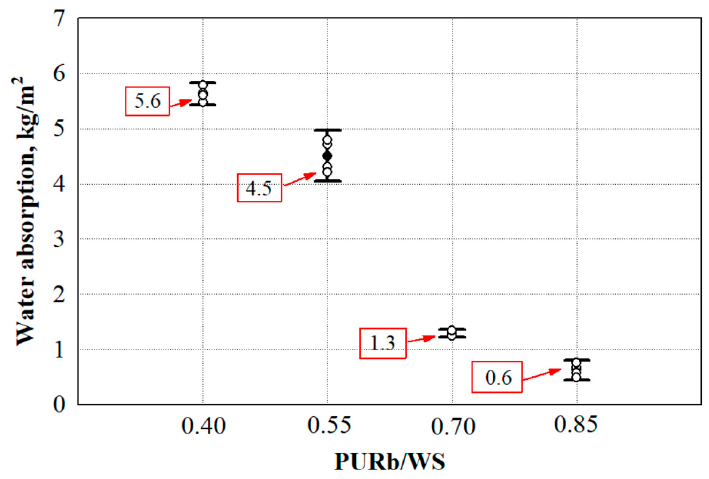
Figure 9. Surfaces of PUR biocomposite foams after tensile test: ( a ) 0.40 PURb/WS and ( b ) 0.70 PURb/WS.